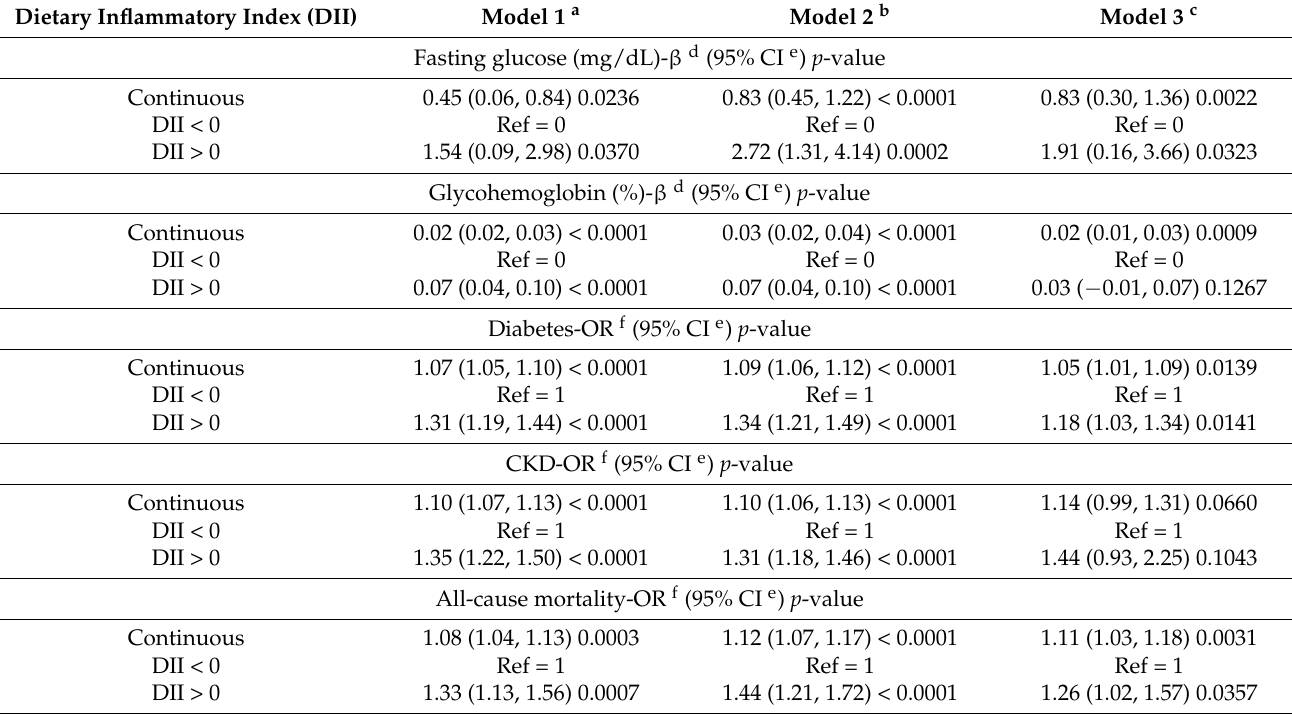
Table 2. The relationship between dietary inflammatory index and